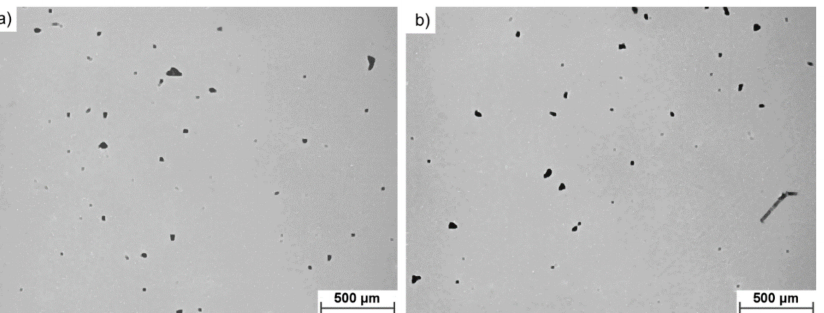
Figure 9. Representative micrographs of porosity of investigated materials, ( a ) FRESH and ( b ) USED Ti6Al4V, showing no apparent difference in porosity morphology between investigated samples.